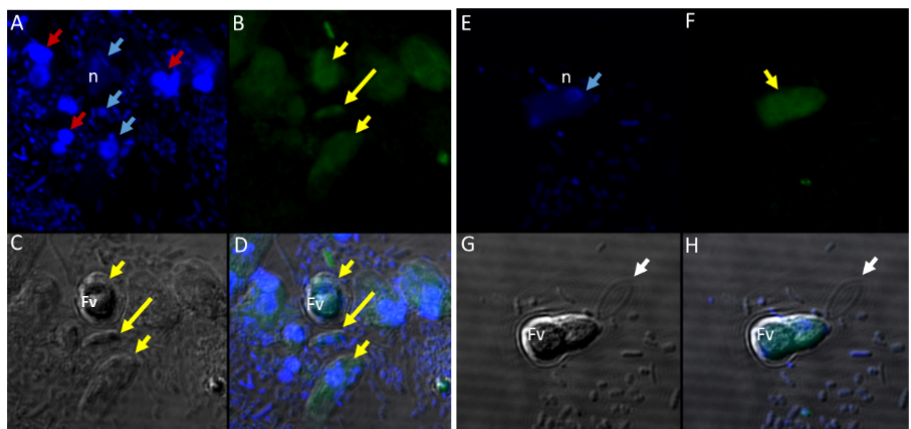
observed on some P. caudatus trophozoites.